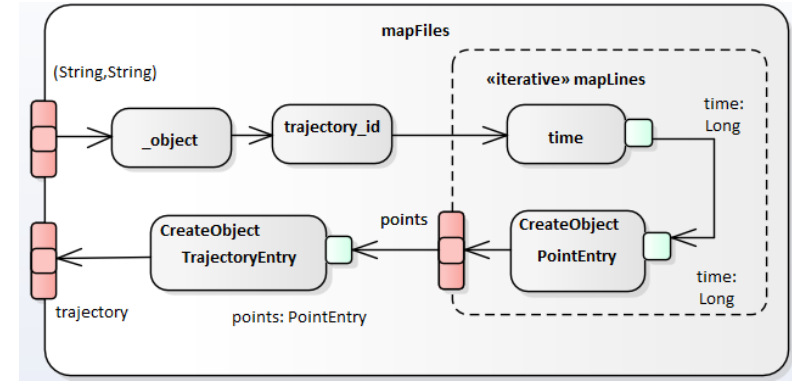
Figure 4. The creation of the